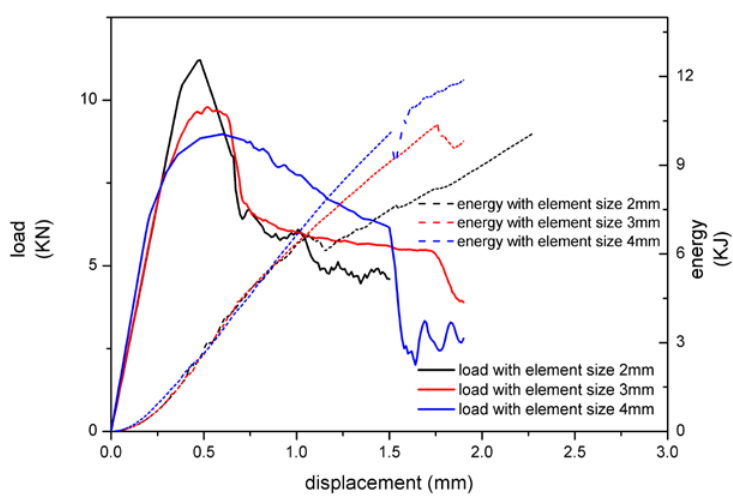
Figure 9. The relationship between load, energy absorption, and displacement with MAT 185.